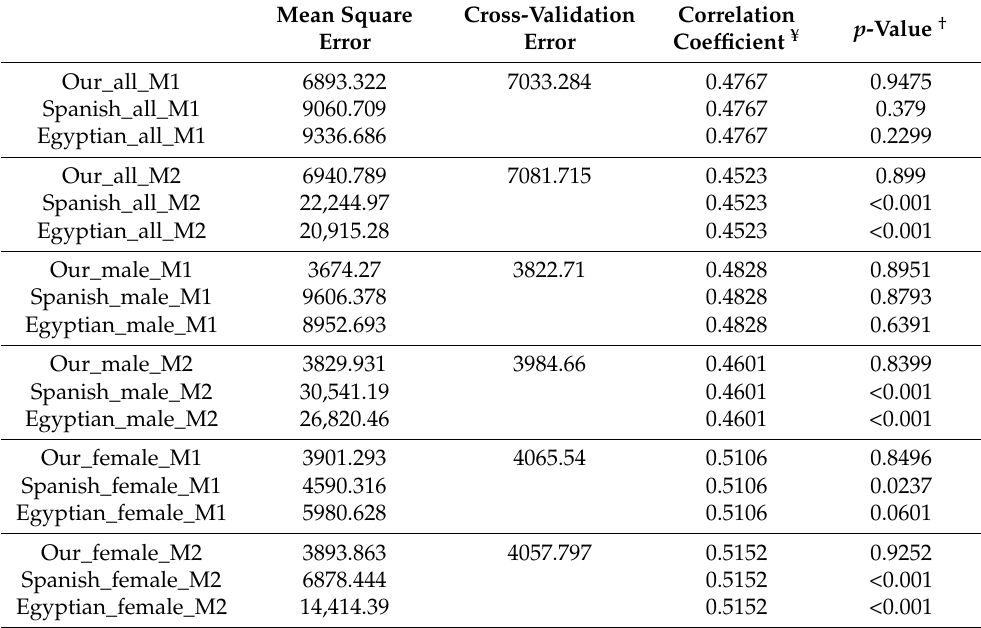
Table 6. Mean square error (Korean versus Spanish and Egyptians) and cross-validation error (Korean validation for the total